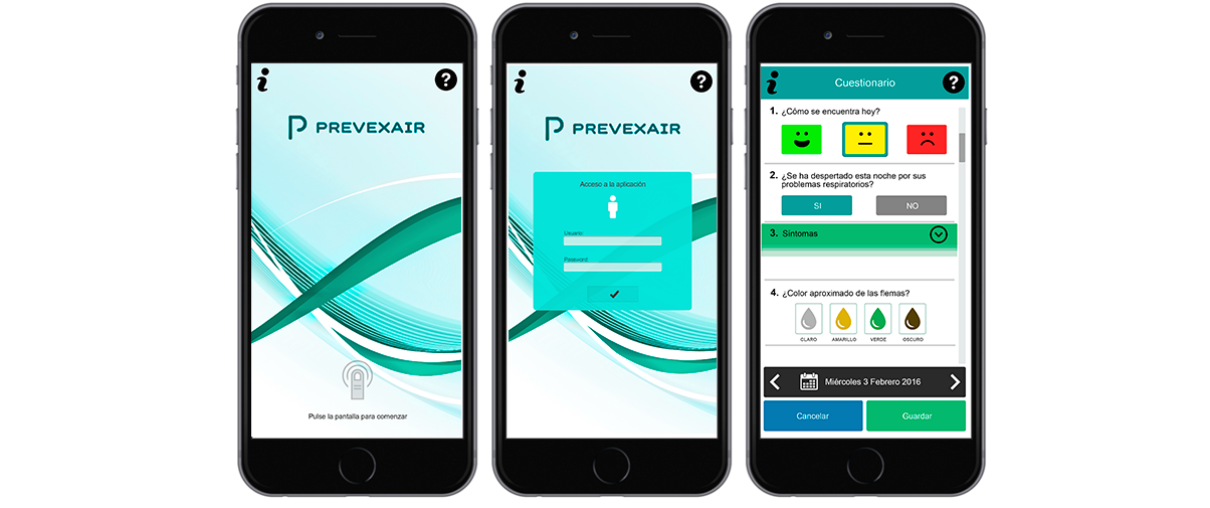
Figure 1. Screenshots of the Prevexair app in a smartphone: initial